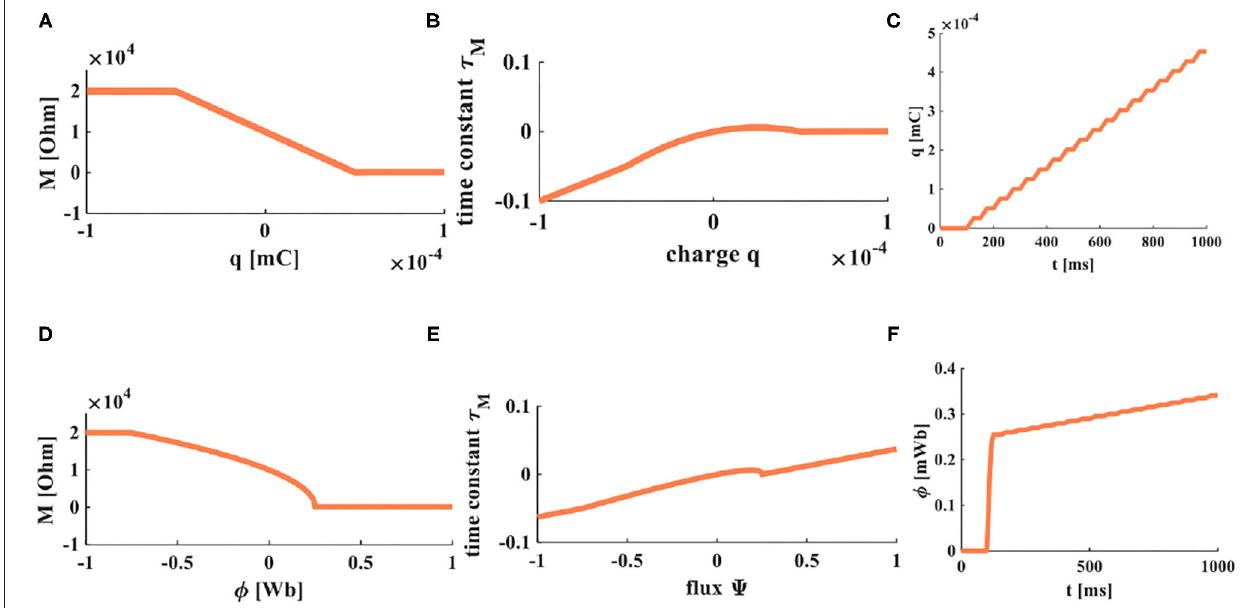
FIGURE 3 | The accumulation processes of charge and flux. (A) The relationship between charge and memristor. (B) The relationship between the time constant and charge. (C) When a series of pulses is applied on a memristor, the accumulation process of charges. (D) The relationship between flux and memristor. (E) The relationship between the time constant and flux. (F) When a series of pulses is applied on a memristor, the accumulation process of